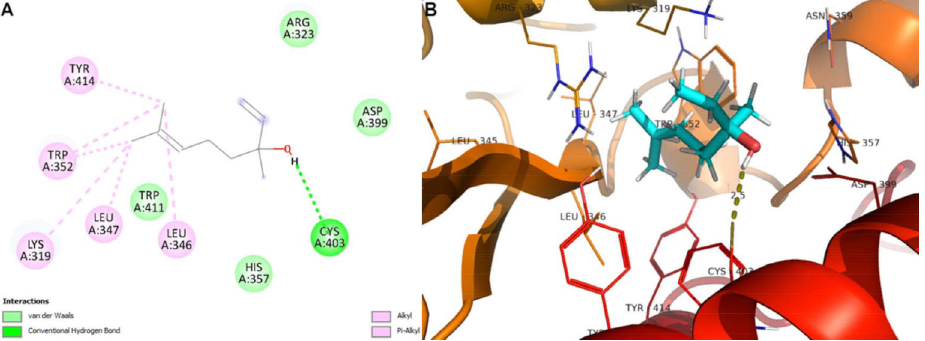
Figure 6. Molecular docking analysis. A , Two-dimensional interactions. B , Three-dimensional representation of linalool respective interactions in the D 14-sterol reductase active site. Dotted yellow: hydrogen-bond interactions.